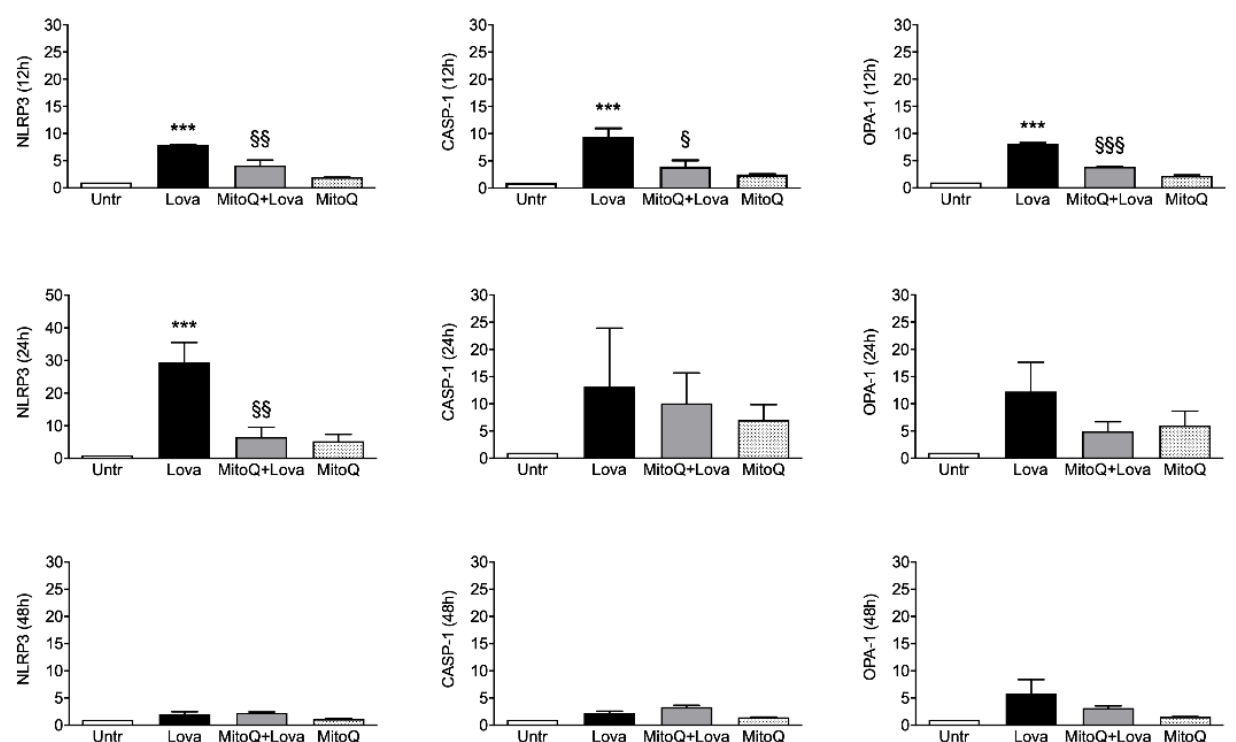
Figure 3. Relative quantification by qPCR of NLRP3, OPA-1 and CASP-1 genes in DAOY cell line ( N = 4 independent experiments). DAOY cells were incubated for 12, 24 and 48 h with lovastatin and Mitoq and afterward collected for RNA extraction and quantification. Results are reported as mean ± SD. Statistically significant p -values are shown (Lova vs. Untreated: *** p < 0.001; MitoQ + Lova vs. Lova: § p < 0.05; §§ p < 0.01; §§§ p < 0.001 based on one-way ANOVA, post-test Bonferroni). Abbreviations: Untr, untreated; Lova, lovastatin; NLRP3, NACHT, LRR and PYD domains-containing protein